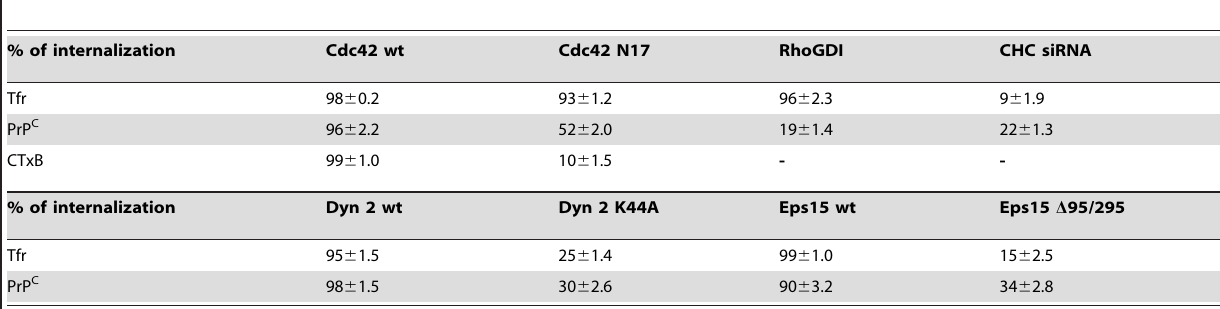
Table 1. Internalization of PrP C is dependent on Cdc-42, Rho, Dyn 2, Eps15 and clathrin.